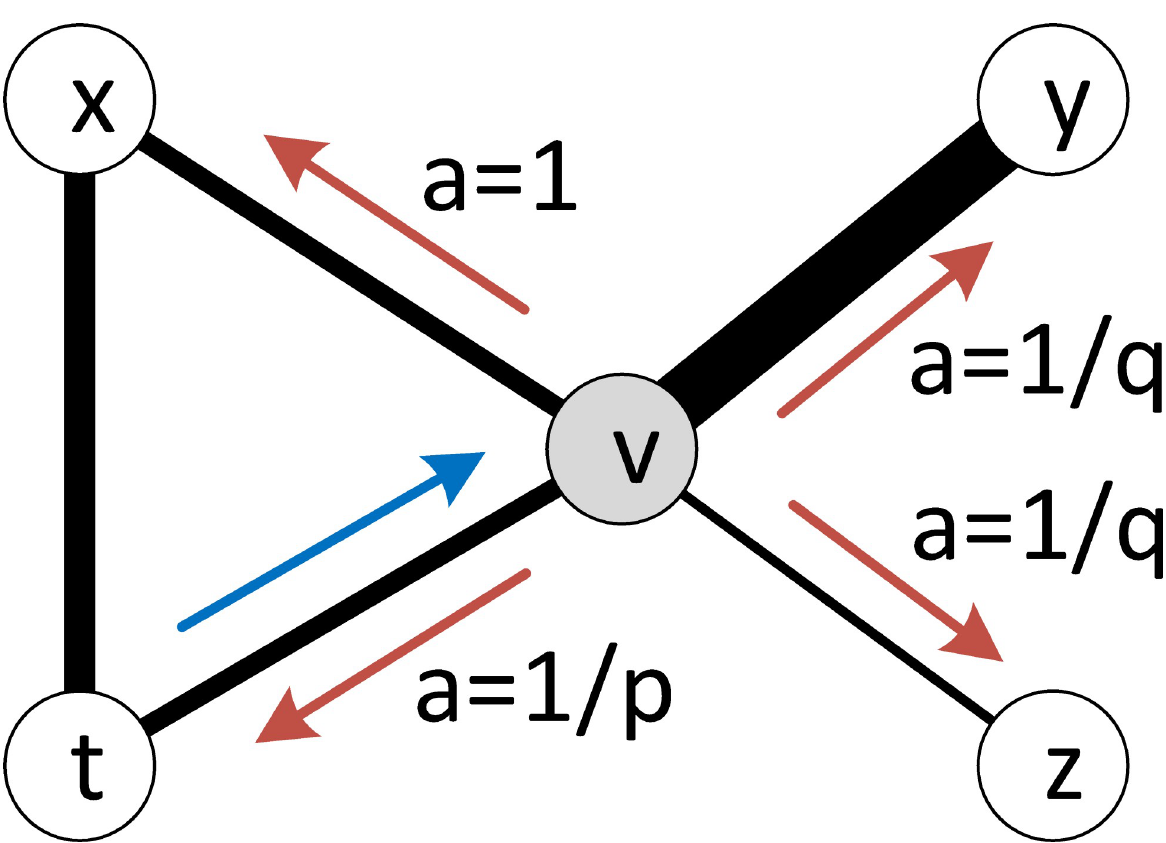
Fig 5. Sampling strategy of random walks in the Node2Vec model. The walk just transitioned from node < t > to node < v > and is now evaluating its next step out of node < v > . The transition probability from < v > to any one of its neighbors (i.e., < t > , < x > , < y > , and < z > ) depends on the search bias a and the edge weight between them (thicker lines indicate larger edge